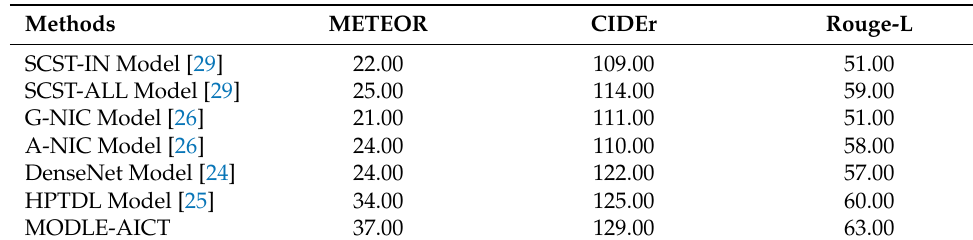
Table 5. Classification analysis of MODLE-AICT algorithm with approaches to MS-COCO 2014 dataset.